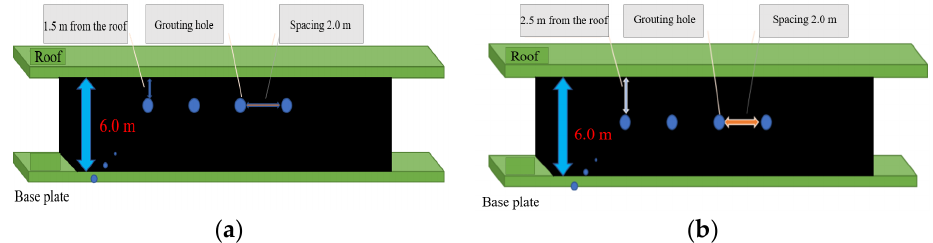
Figure 12. Reinforcement model of single-row grouting pipe: ( a ) 1.5 m from the roof; ( b ) 2.5 m from the roof.